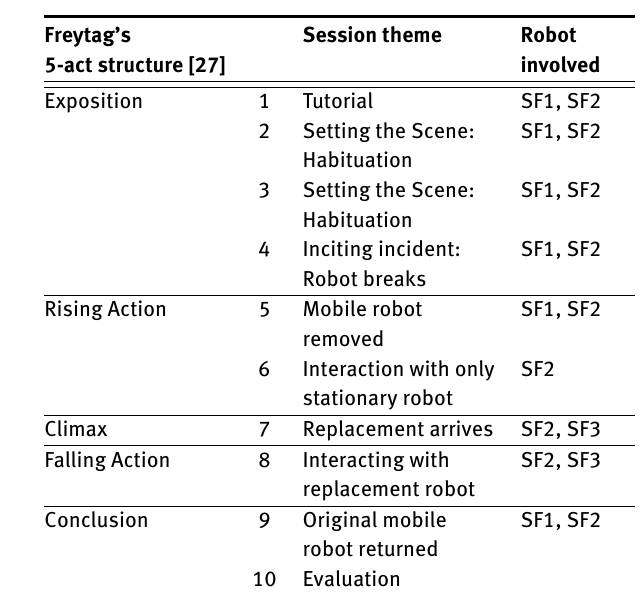
Table 2: Sessions in the